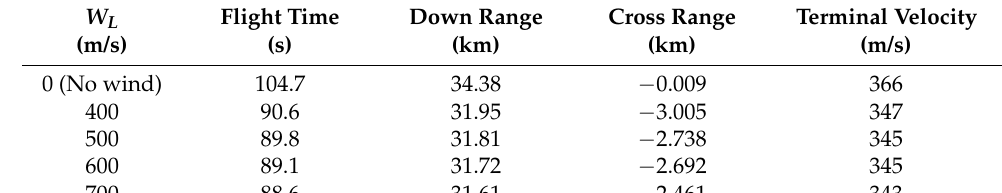
Table 8. Main ballistic parameters with different H T .